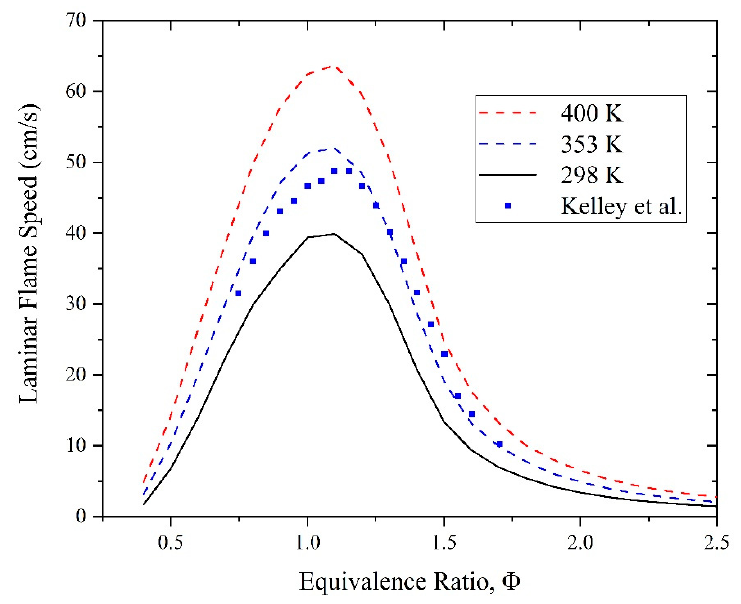
Figure 1. The laminar flame speed of n -pentane–air at equivalent ratios of 0.4–2.5 and unburned gas temperatures of 298, 353, and 400 K, respectively.